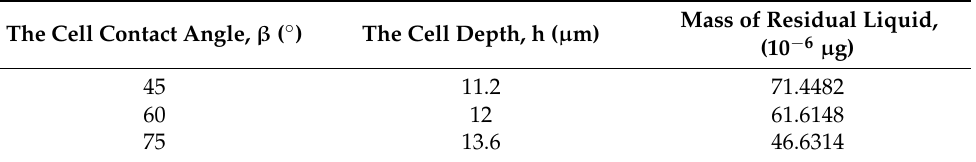
Table 3. The critical value of cell depth under different cell contact angles and the remaining cell volume under the combination of the